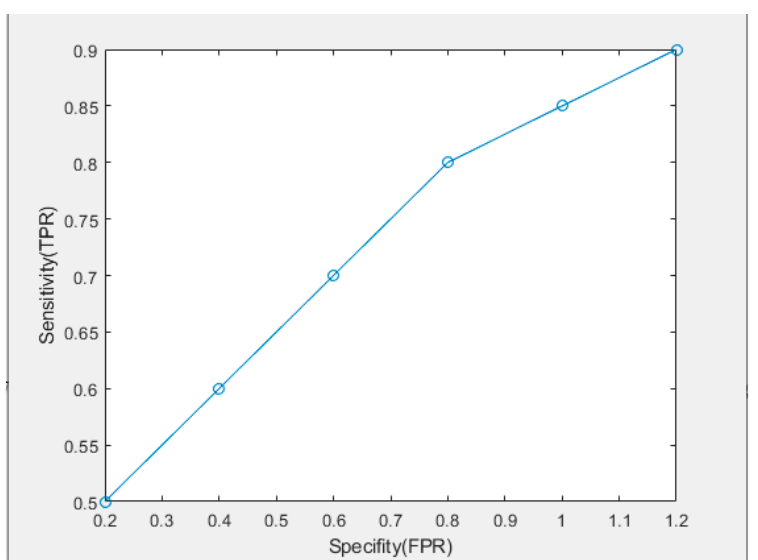
Figure 12. Final report for patient.